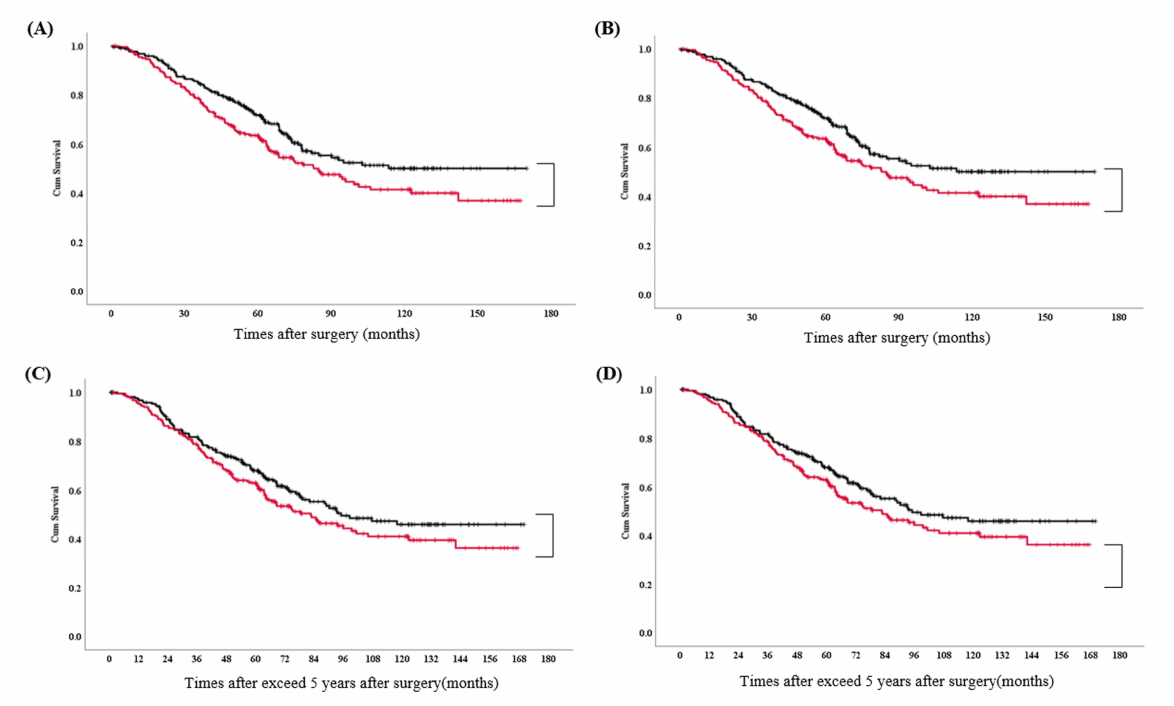
Figure 4. Kaplan–Meier curves. Overall survival curve ( A ) and disease-free survival curve ( B ) stratified by the degree of mediastinal lymph node dissection. Overall survival curves after 5 years of follow-up, before ( C ) and after ( D ) propensity adjustment. Black line: lobe-specific lymph node dissection; red line: systemic lymph node